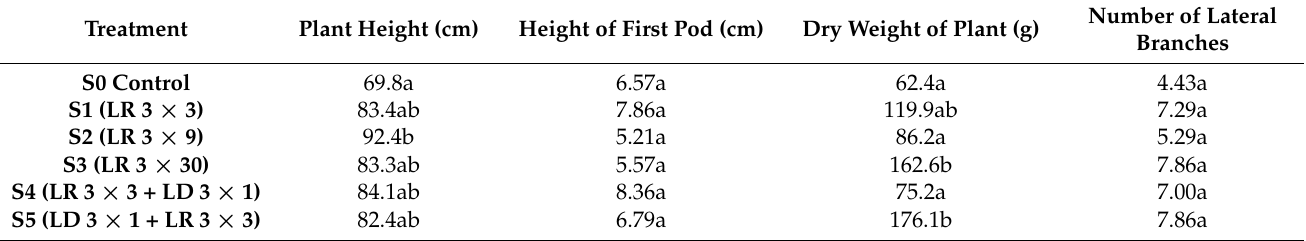
Table 3. Biometric features of the plants depending on the type of light stimulation of seeds.